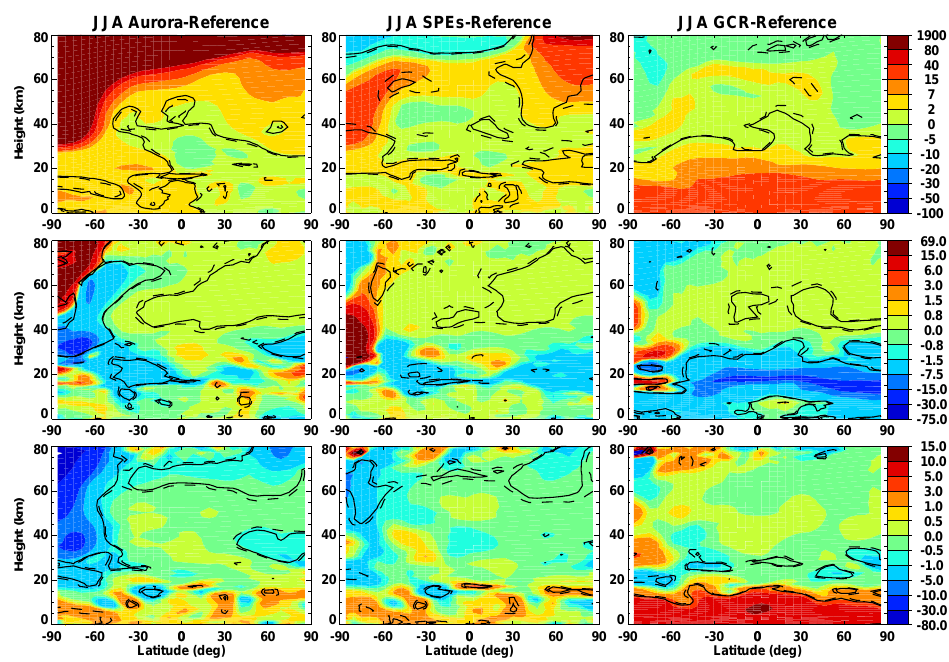
Fig. 7. Run mean, June–August mean compared to the reference run for auroral zone electrons (left), SPEs (center) and GCR (right) showing NO y (top, %), HO x (middle, %) and O 3 (bottom, %).